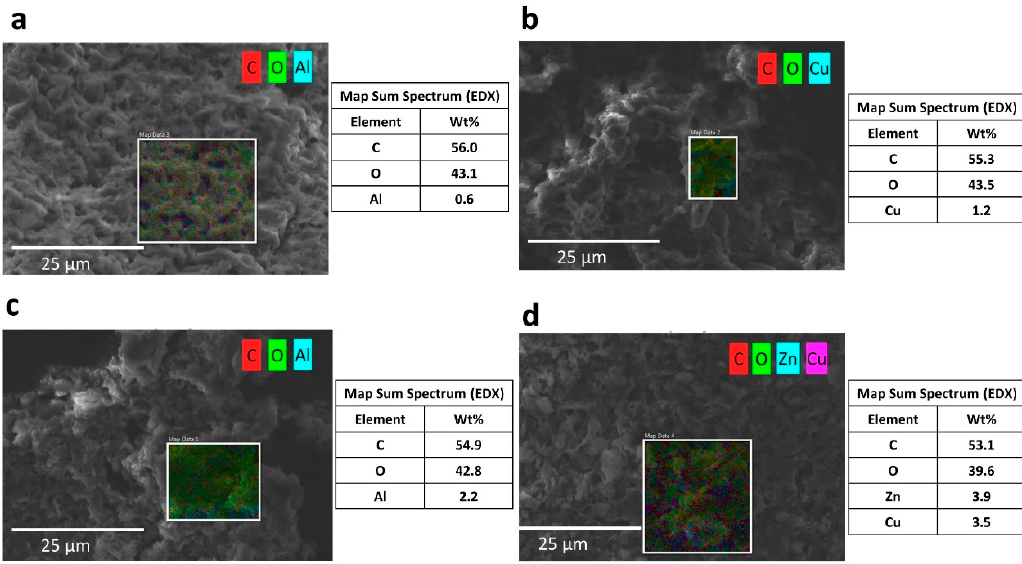
Figure A2. Scanning electron microscopy coupled with energy-dispersive X-ray spectroscopy (SEM-EDX) of the adsorbents after adsorption experiments: GO for ( a ) Al and ( b ) Cu removal, and GO/ZnO for ( c ) Al and ( d ) Cu removal.